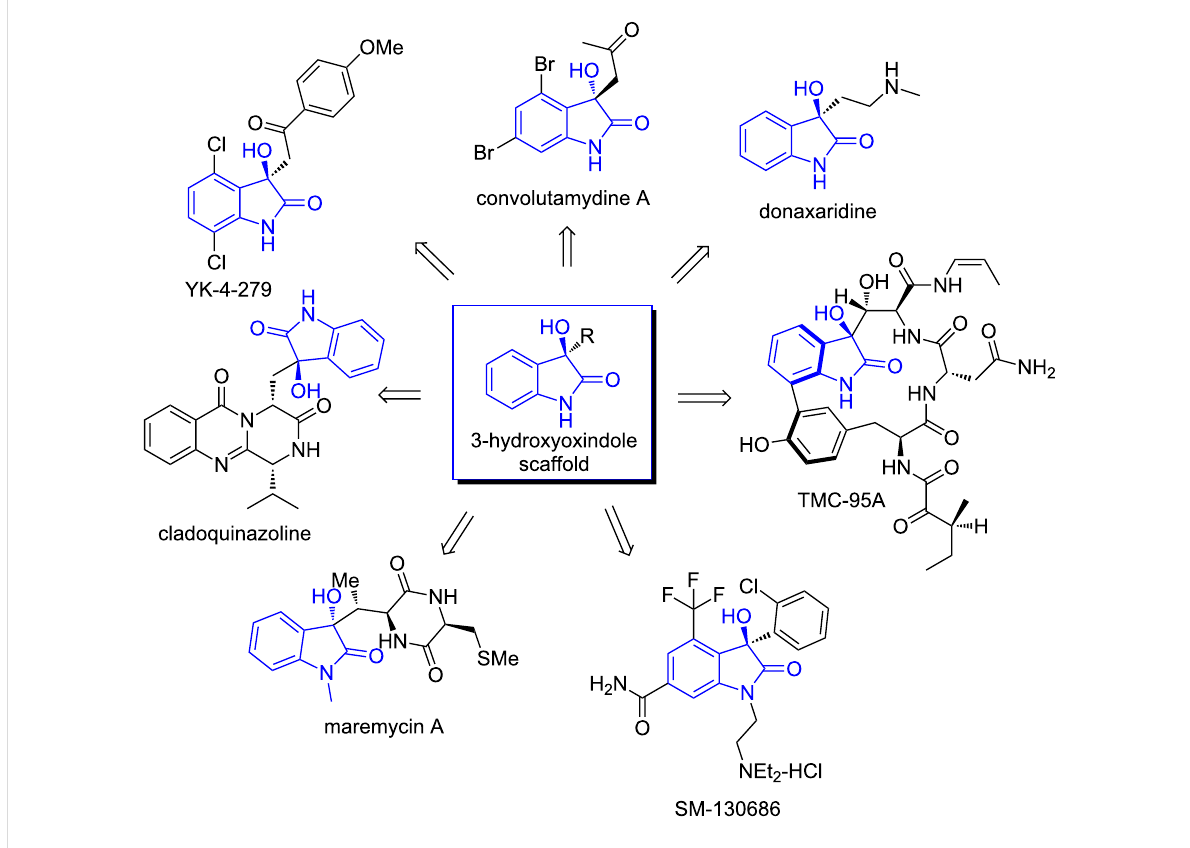
Figure 1: 3-Hydroxyoxindole-containing natural products and biologically active molecules.